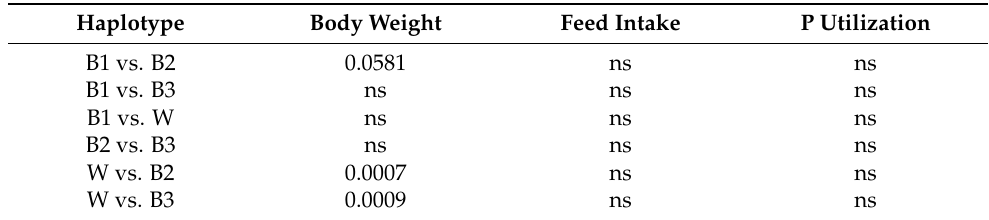
Table A3. p -values of pairwise comparisons of body weight, feed intake and phosphorus utilization between haplotypes independent of the period. Tukey post hoc was used for testing.